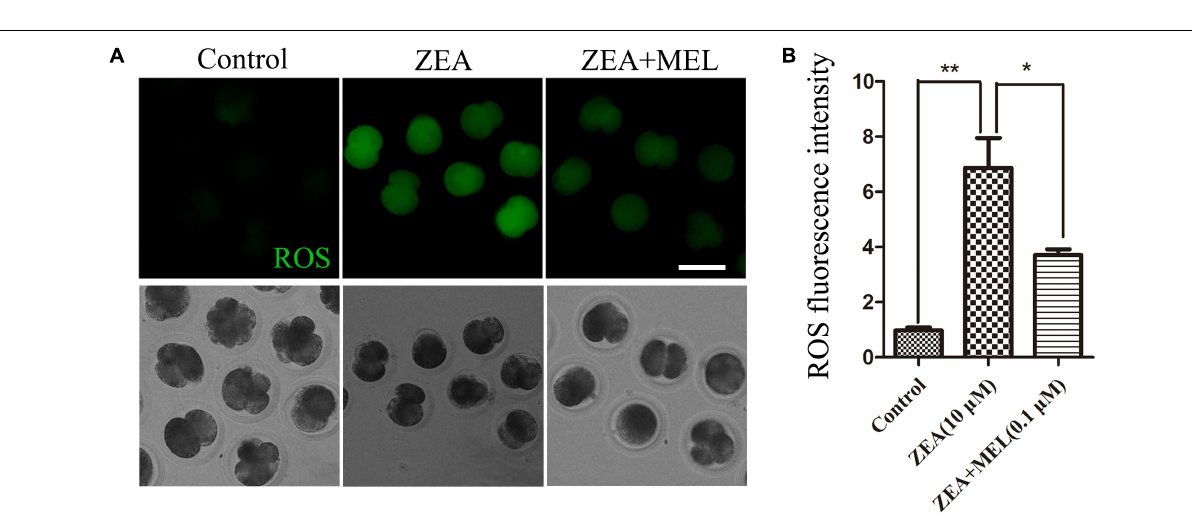
Frontiers in Pharmacology |